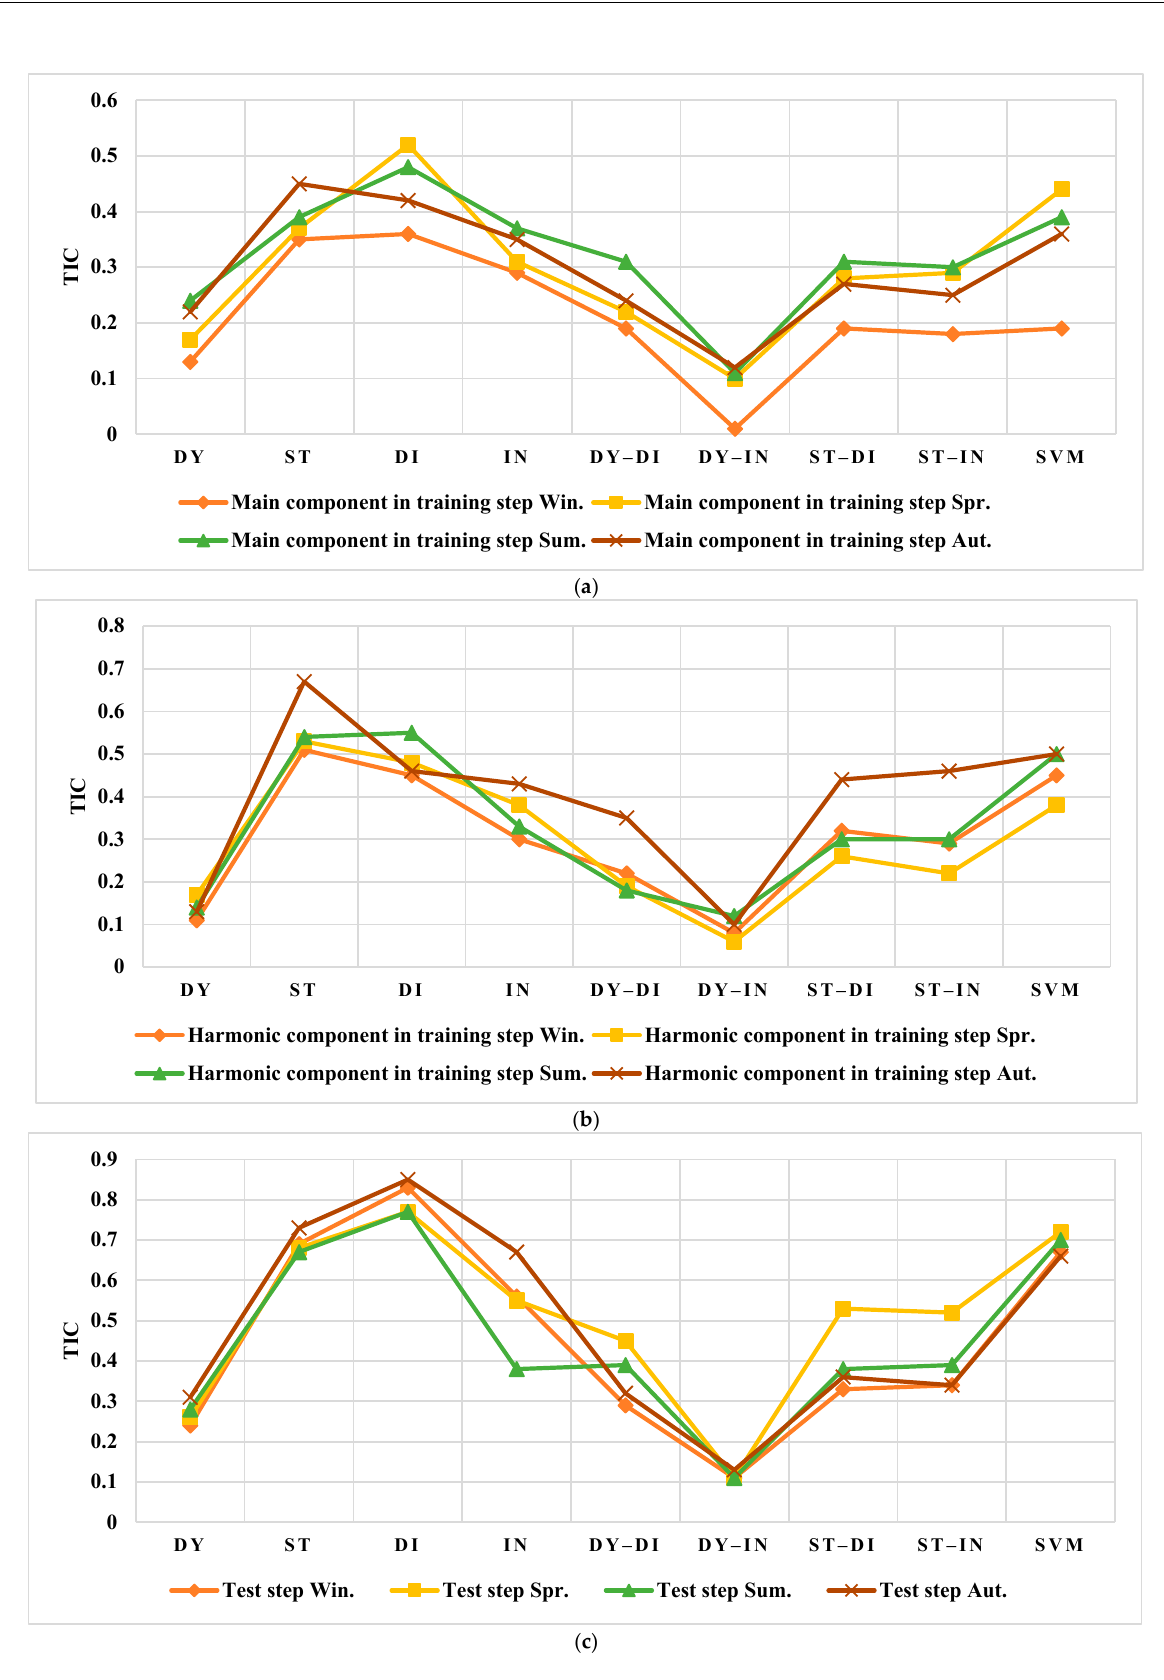
Figure 16. The results of TIC for Spain: ( a ) Main Component in training step, ( b ) Harmonic Com- ponent in training step, ( c ) Test step